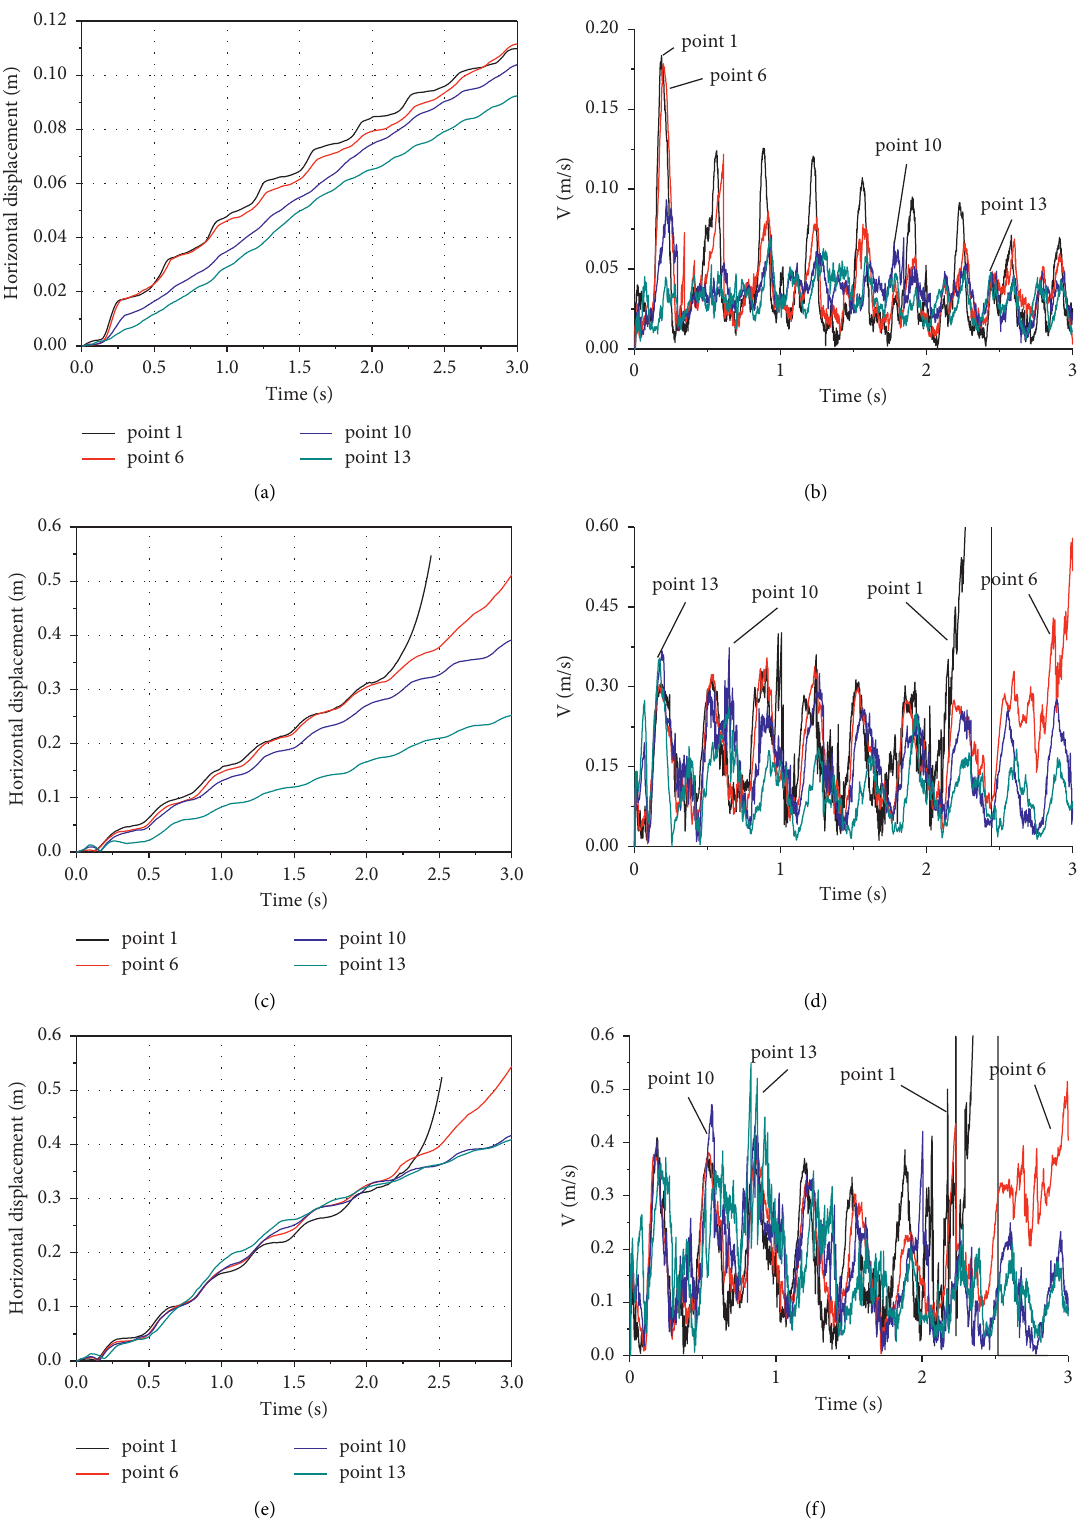
Figure 6: Displacement and velocity time history of monitoring points in the slope under different moisture contents. (a) Displacement curve at 5% moisture content. (b) Velocity curve of 5% moisture content. (c) Displacement curve of 8% moisture content. (d) Velocity curve of 8% moisture content. (e) Displacement curve of 12% moisture content. (f) Velocity curve of 12% moisture